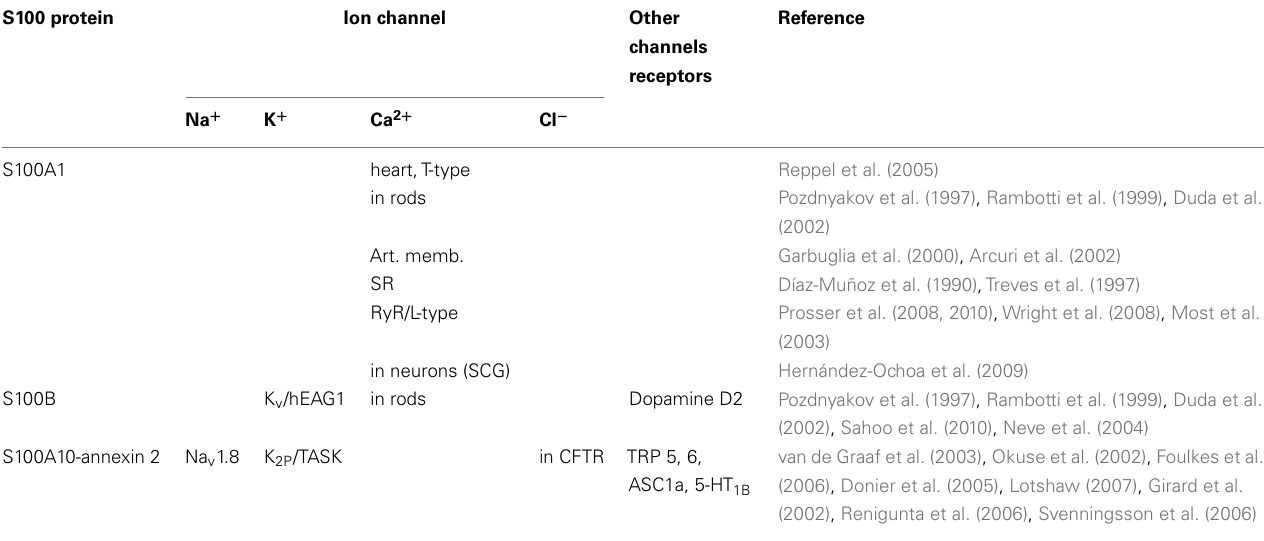
Table 1 | Interactions of S100 proteins with ion channels 1